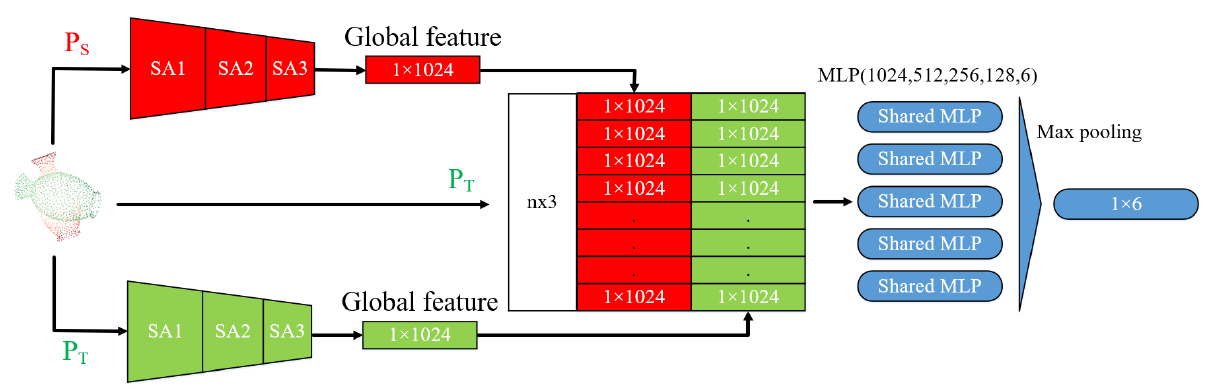
Figure 1. SAP-Net architecture. It consists of two parts: a feature extraction layer and transform prediction layer. SAP-Net uses the SA layer in PointNet++ as the feature extraction layer and then connects the global features and the initial template point cloud. Finally, it uses the PointNet structure as the transform prediction layer to obtain the rigid transformation.